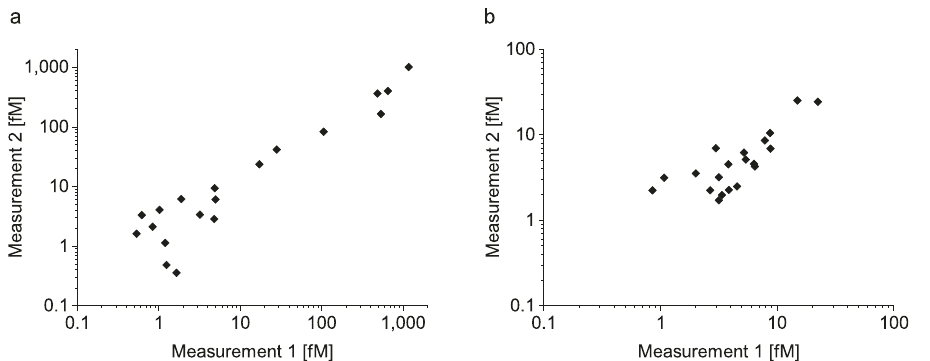
Fig. 3 Repeated measurements of aSyn and Tau aggregates in CSF yield highly reproducible results. We tested the inter-assay variance of the sFIDA assay for a aSyn and b Tau aggregates. Two independent measurements of 20 CSF samples by the same technician in the same